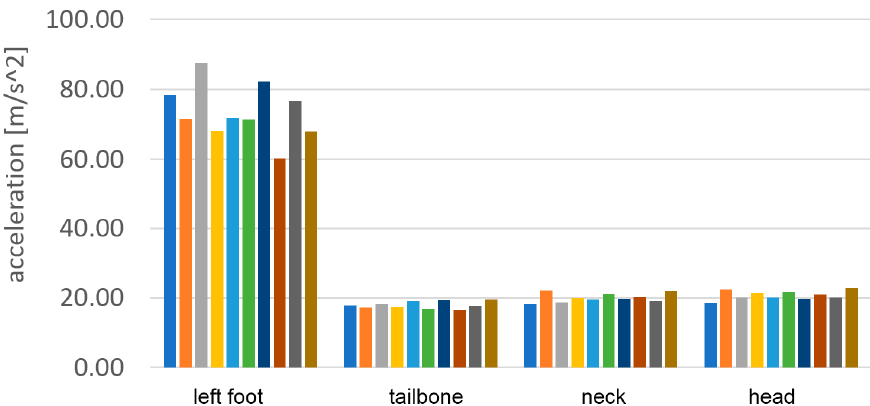
Figure 30. The vertical component of the head acceleration during 10 subsequent steps of the single passage with bare feet.